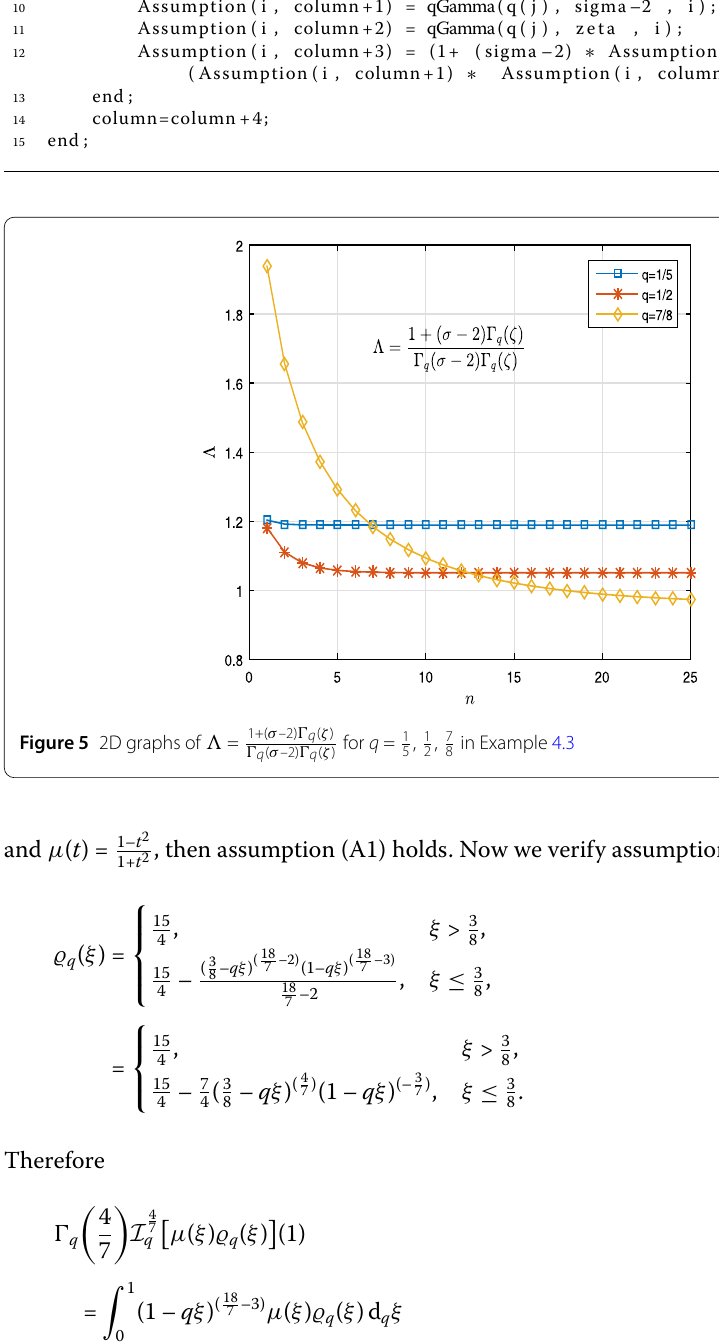
Algorithm 7 MATLAB lines for calculating values of (cid:19) = 1+( σ –2) (cid:12) q ( ζ ) variable in Example 4.3